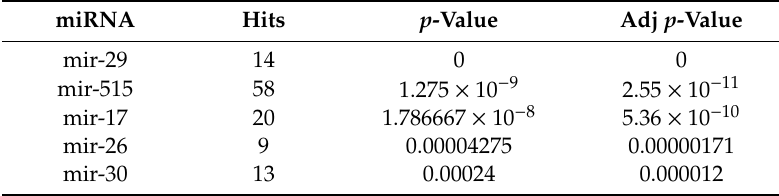
Mel-18 / DNMT-1, MLL fusion proteins, MYC / HDAC3 / EZH2, MYST3, p50 p53, PRC2, PRMT5, RNAPII, sp1, and SUV39H1. Table 3. miRNet epi-miRNA network analysis Table 3. miRNet epi-miRNA network analysis outcome.